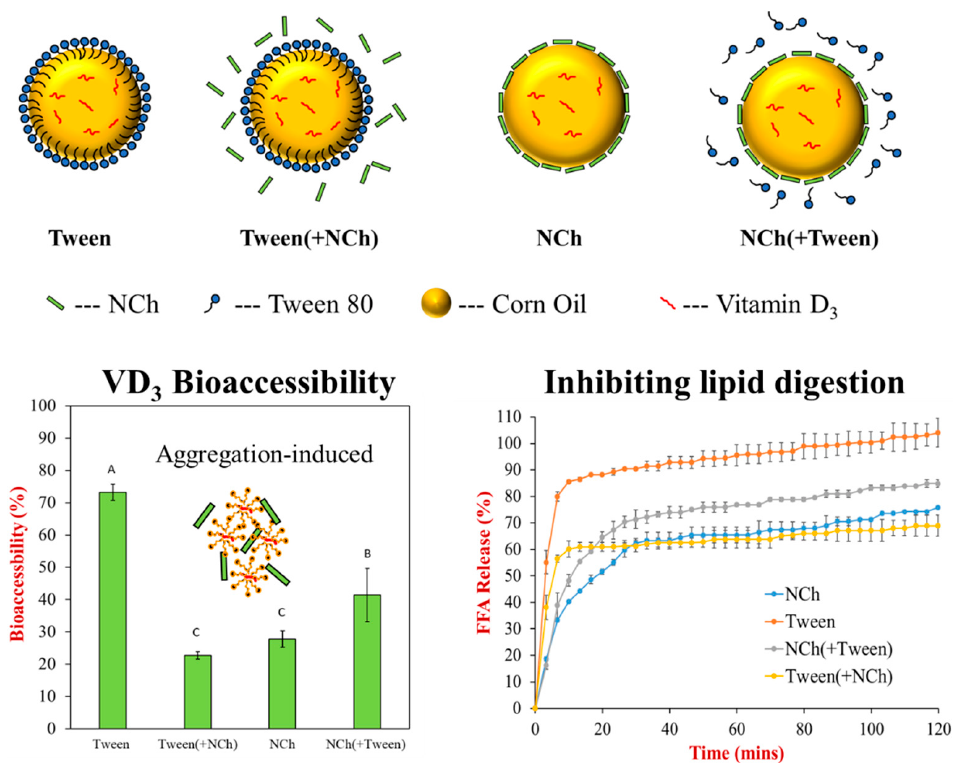
Figure 5. Impact of nanochitin (free or adsorbed) on lipid digestion and vitamin D 3 bioaccessibility in oil-in-water emulsions. Adapted from reference